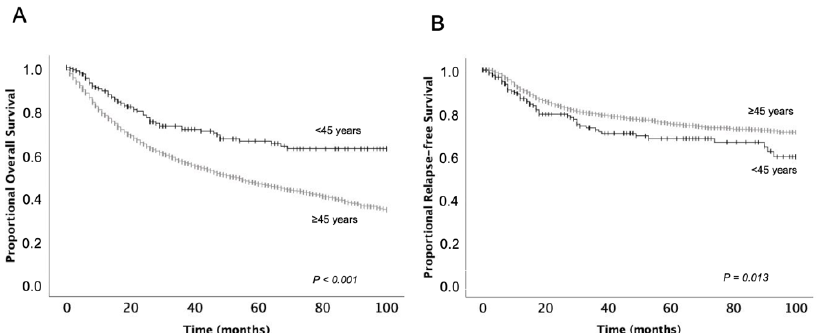
Figure 1. Overall survival ( A ) and relapse-free survival ( B ) of patients aged under 45 years in comparison to older patients.